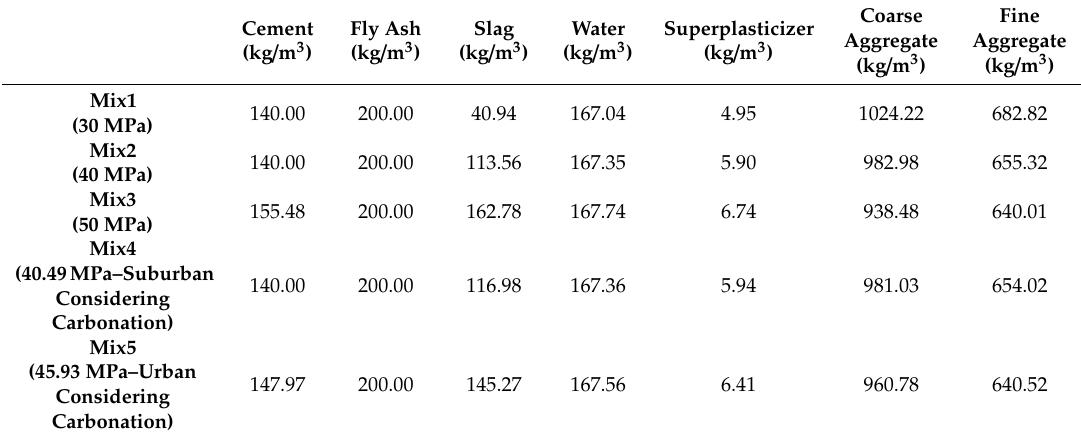
Table 6. The mixtures of concrete.